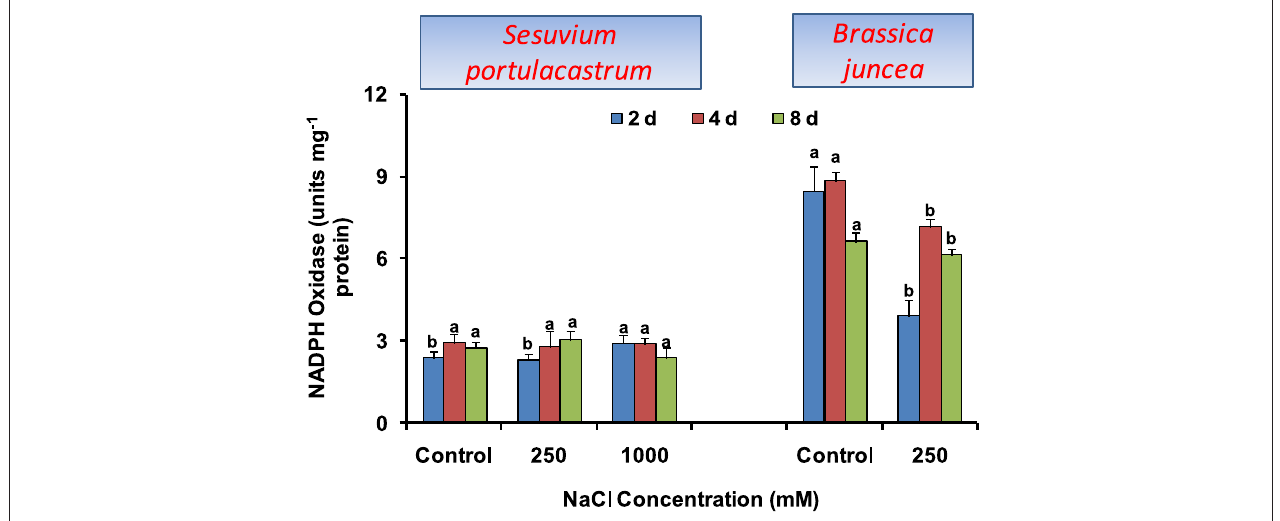
FIGURE 2 | Time dependent modulation of NADPH oxidase activity in NaCl exposed Sesuvium portulacastrum and Brassica juncea . All values represent the mean of three replicates. Different letters indicate significantly different values at a particular duration (DMRT, P = 0 .01).